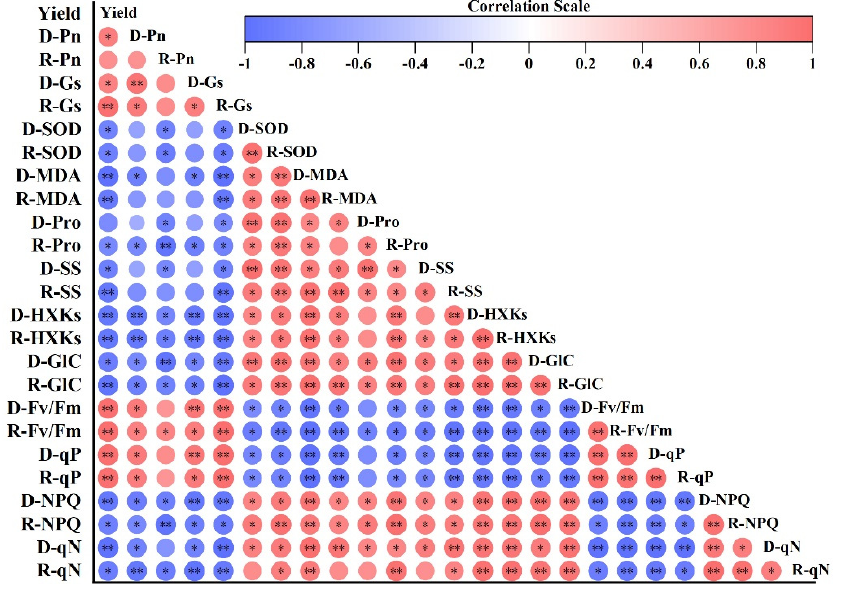
Figure 5. Correlation between the physiological indicators and yield. D, drought; R, re-watering. * p < 0.05. ** p < 0.01.